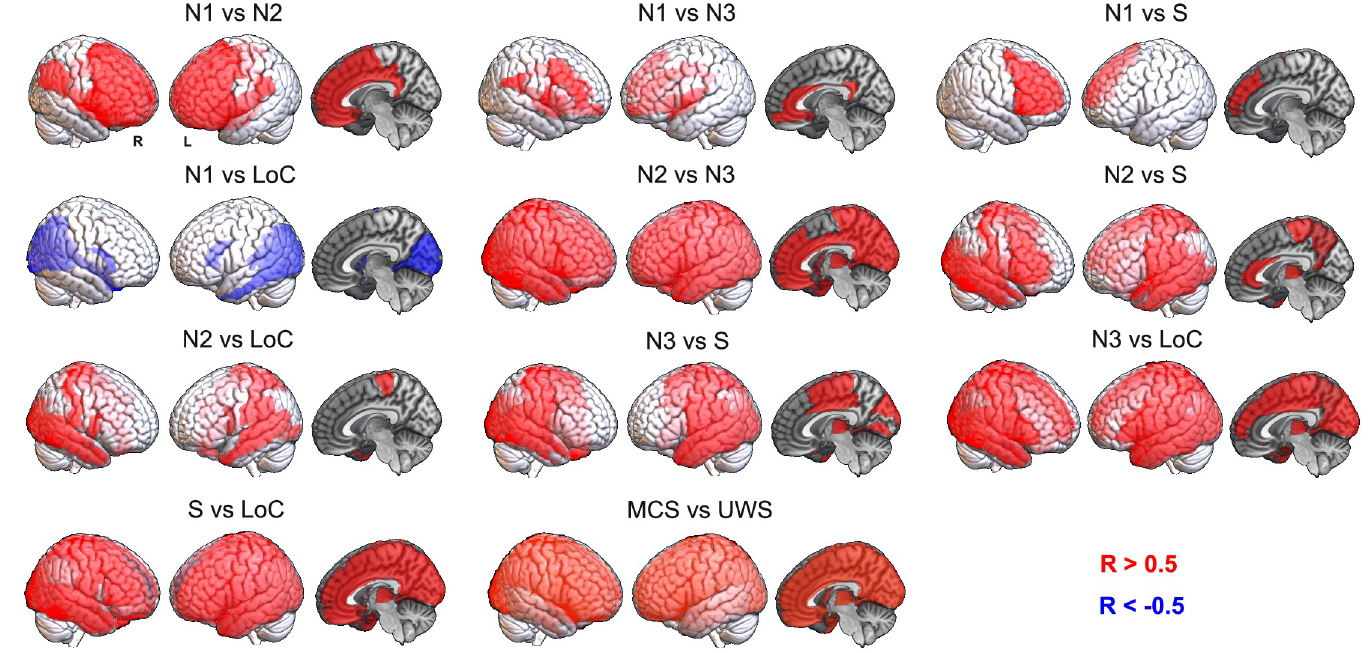
Fig 3. Shared patterns of regional FC changes reflect the progression towards unconsciousness during sleep and propofol-induced anesthesia, but these similarities do not extend to DoC patients. Each panel contains an anatomical rendering of the regions presenting significantly correlated FC changes between the states indicated in the insets. Red indicates a significant positive correlation in regional FC changes (R > 0.5), while blue indicates a significant negative correlation (R < - 0.5).